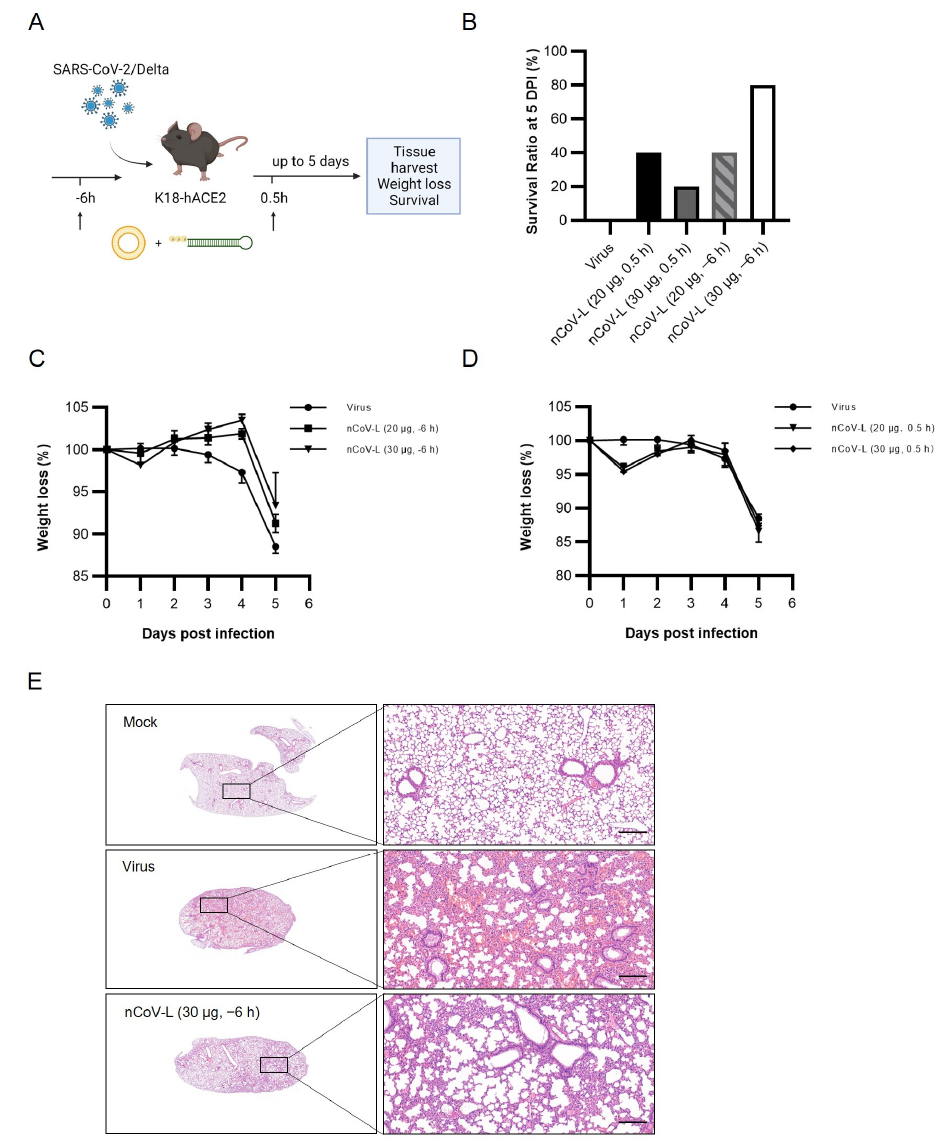
Figure 4. The in vivo antiviral effect of nCoV-L against SARS-CoV-2. ( A ) Experimental scheme. K18- hACE2 mice were intranasally infected with 200 TCID 50 SARS-CoV-2/Delta. 20 µ g or 30 µ g nCoV-L complexed with Lipo were intraperitoneally injected 6 h before or 0.5 h after infection. Survival and weight loss were monitored daily up to 5 DPI when mice infected with virus were all dead.